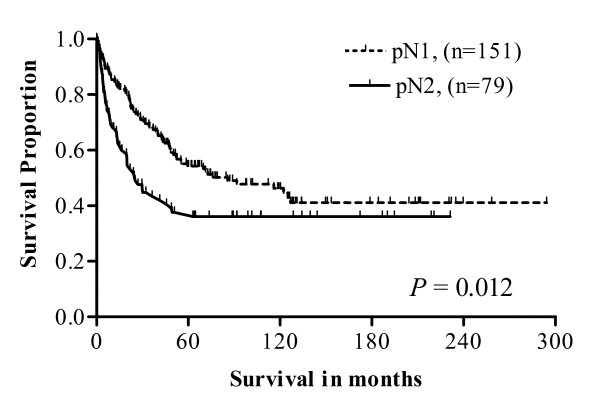
Survival in pN1 vs. pN2 Stage III colon cancers. Kaplan-Meier survival curves demonstrating significant difference in disease-specific survival between Stage III patient groups of pN1 and pN2.